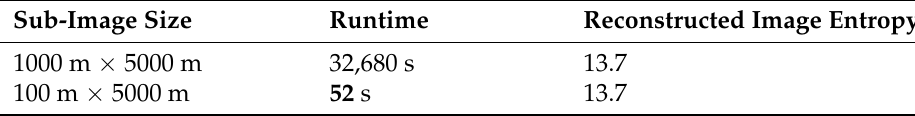
Table 5. Runtime comparison of the estimation algorithm by using different sub-image